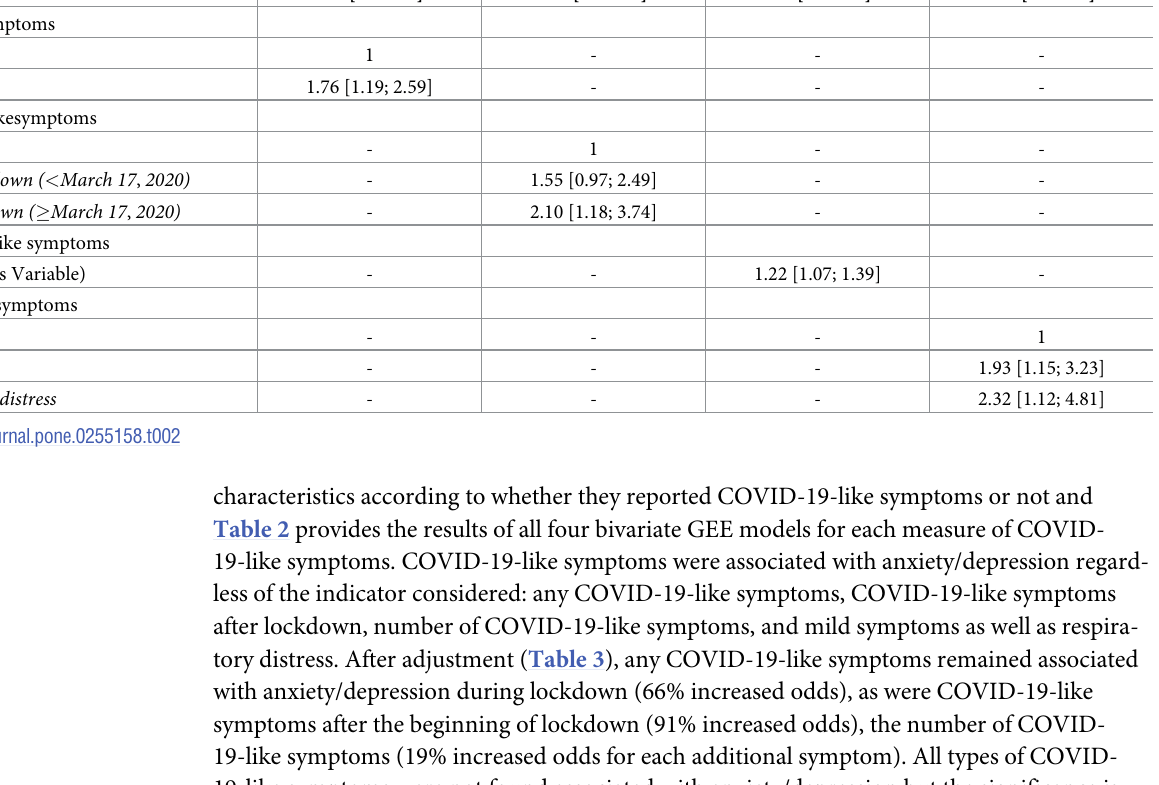
Table 2. COVID-19-like symptoms and anxiety/depression in the TEMPO cohort during the first COVID-19-related lockdown (March-June 2020, France, bivariate GEE models, Odds-Ratio (OR), 95% Confidence Interval (CI)). Measures of COVID-19-like